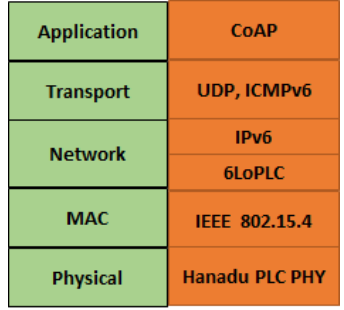
Figure 2. Protocol stack showing 6LoPLC.